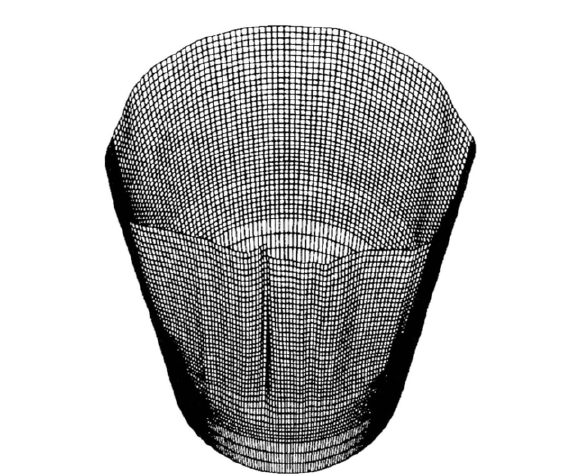
FIGURE 9 Final form of a cylindrical shell